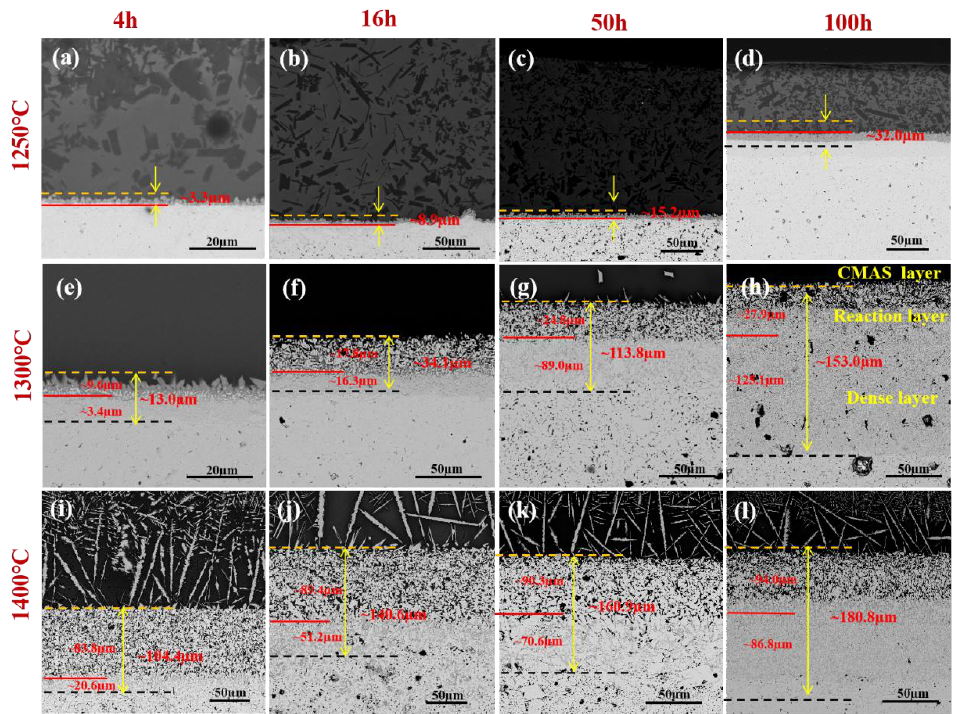
Figure 4. Cross-sectional BSE images of Hf 6 Ta 2 O 17 ceramic after CMAS corrosion: ( a ) at 1250 °C for 4 h; ( b ) at 1250 °C for 16 h; ( c ) at 1250 °C for 50 h; ( d ) at 1250 °C for 100 h; ( e ) at 1300 °C for 4 h; ( f ) at 1300 °C for 16 h; ( g ) at 1300 °C for 50 h; ( h ) at 1300 °C for 100 h; ( i ) at 1400 °C for 4 h; ( j ) at 1400 °C for 16 h; ( k ) at 1400 °C for 50 h; ( l ) at 1400 °C for 100 h. The CMAS infiltration depth is measured from the initial specimen surface (yellow dash lines) to the infiltration front (black dash lines).